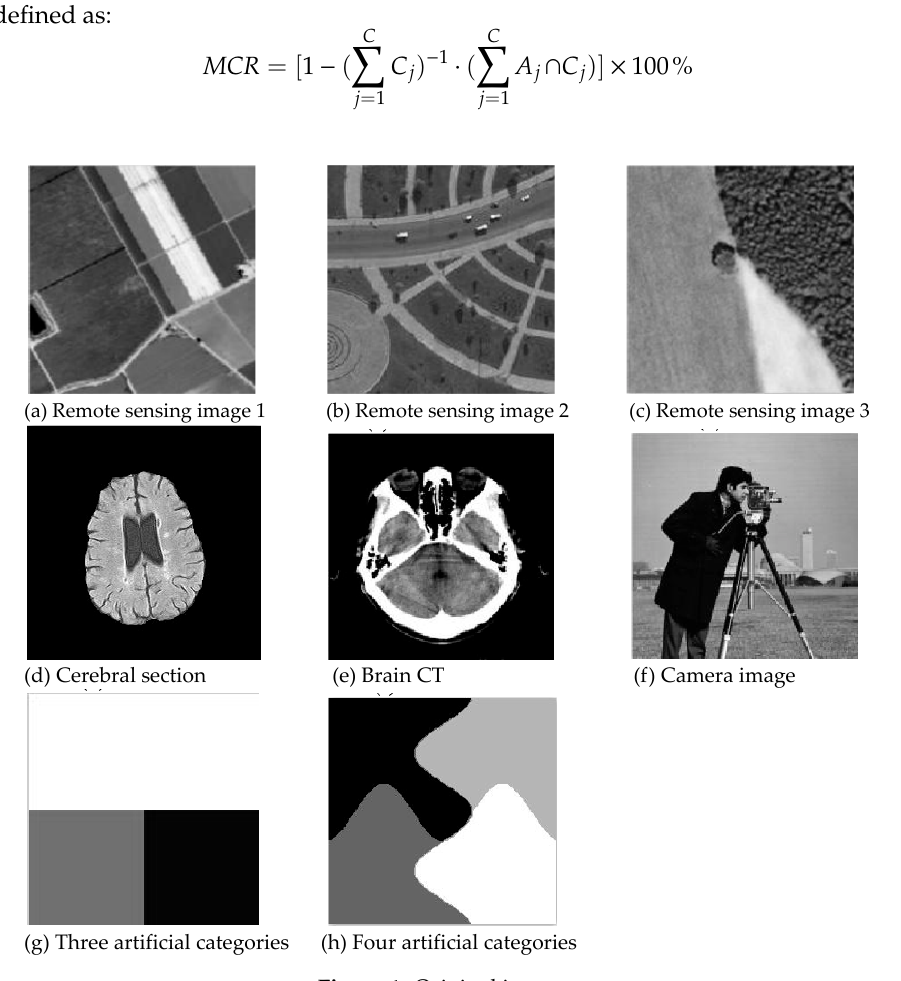
Figure 1. Original images.